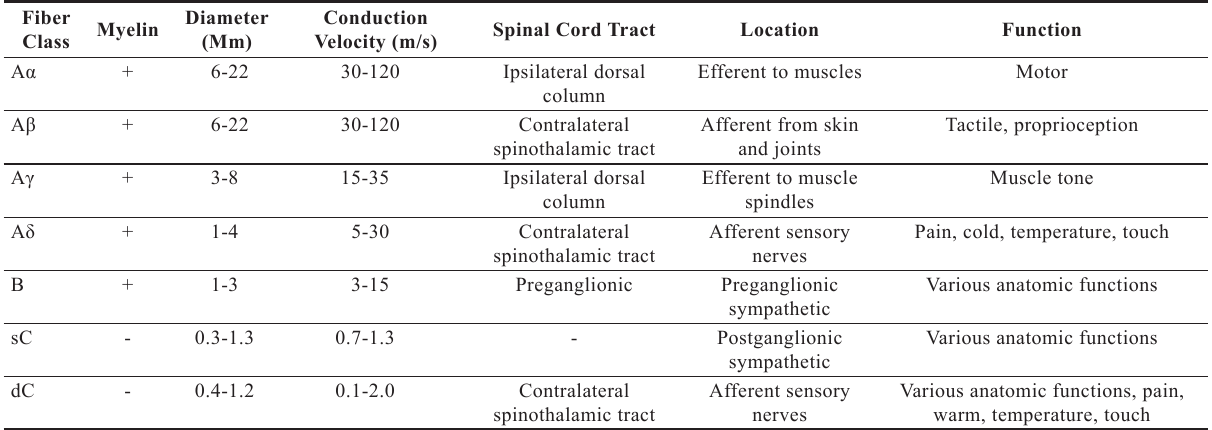
Table 1. Nerve Fiber Types and